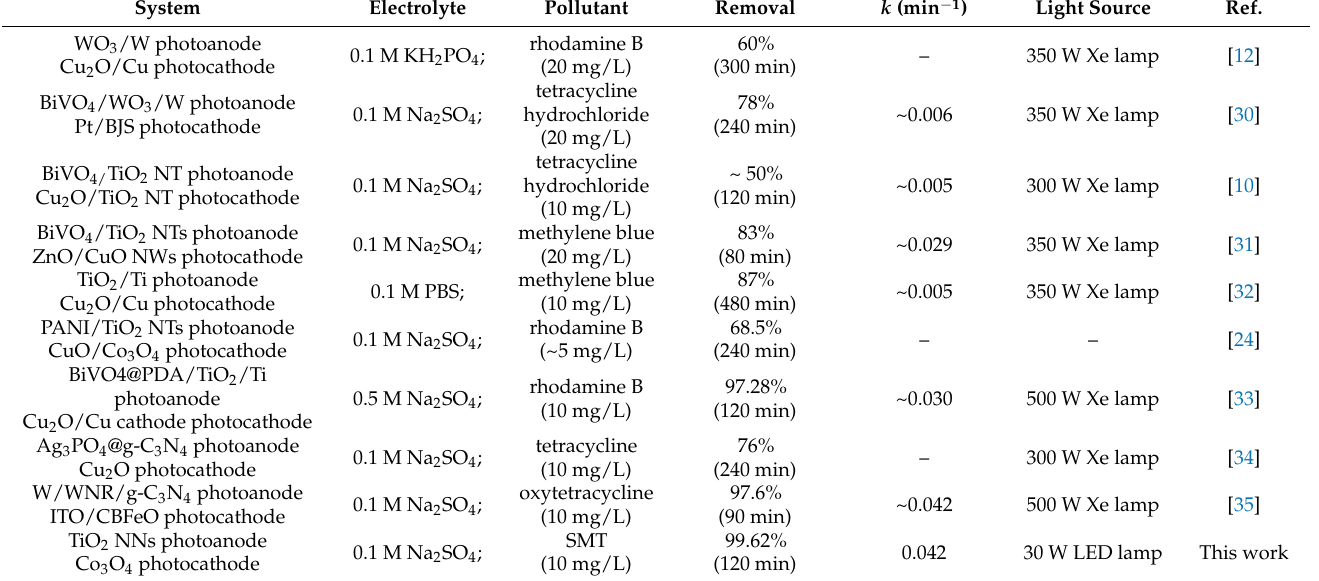
Table 1. The performance comparison of recently self-driven PEC system for wastewater